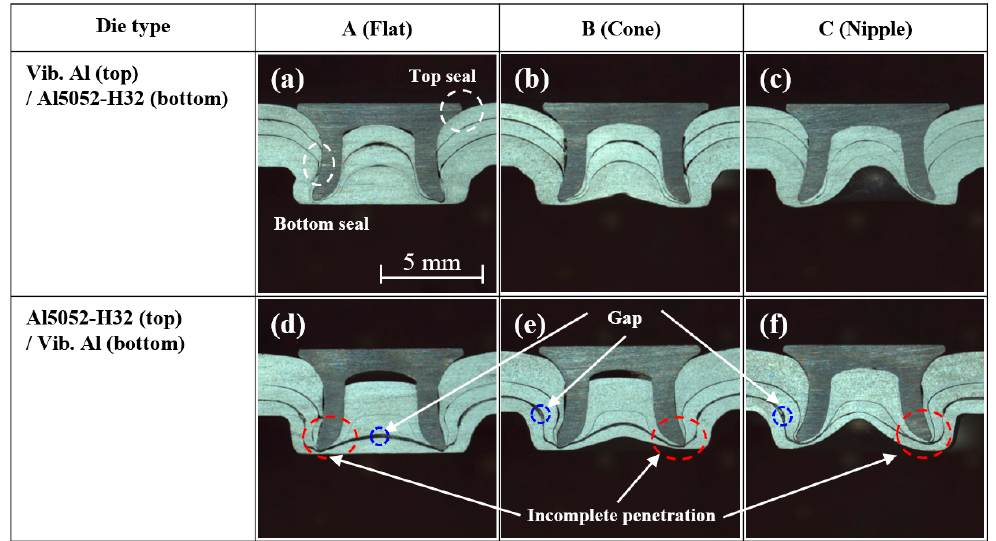
Figure 6. Cross-sectional images of the self-piercing riveted joint between vibration-damping Al and Al5052-H32 with respect to die types and configuration of the panels: ( a , d ) die type A , ( b , e ) die type B , and ( c , f ) die type C .